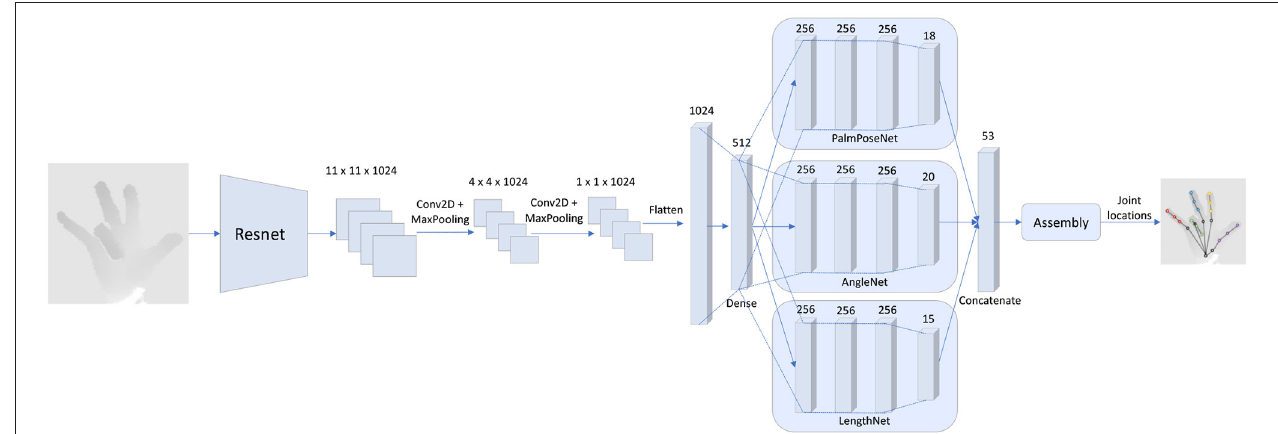
FIGURE 3 | Framework architecture.The proposed architecture uses part of the Resnet50 model for feature extraction. The features then pass through two sets of convolutional layers and max pooling layers and then flattens to a common dense layer. This layer is then fed as input to three sub-nets: (1) The PalmPoseNet, which outputs an 18-dimensional vector corresponding to the 3D positions of the palm joints (root joint, MCPs and CMC), (2) the AngleNet, which outputs a 20-dimensional vector corresponding to the joint angles of the hand and (3) the LengthNet which outputs an 18-dimensional vector corresponding to the length of each finger segment of the hand. The features are then concatenated and sent as input to the assembly which then provides the joint locations as output.